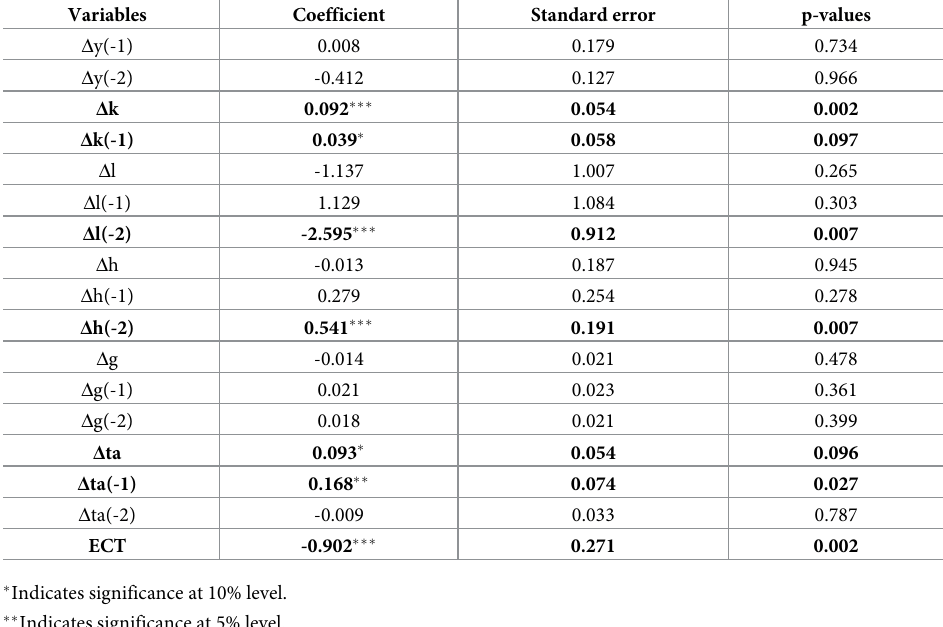
Table 6. Short run ARDL